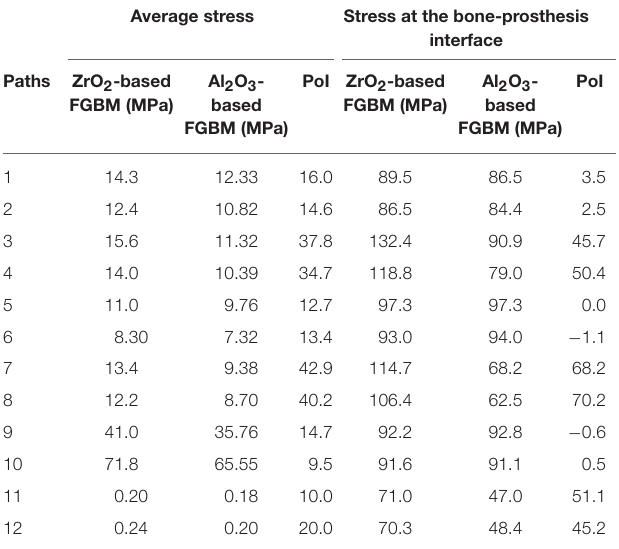
TABLE 4 | Average and bone-prosthesis interface stresses along assumed paths at alumina-based and zirconia-based proposed FG biomaterials [PoI: Percent of increase